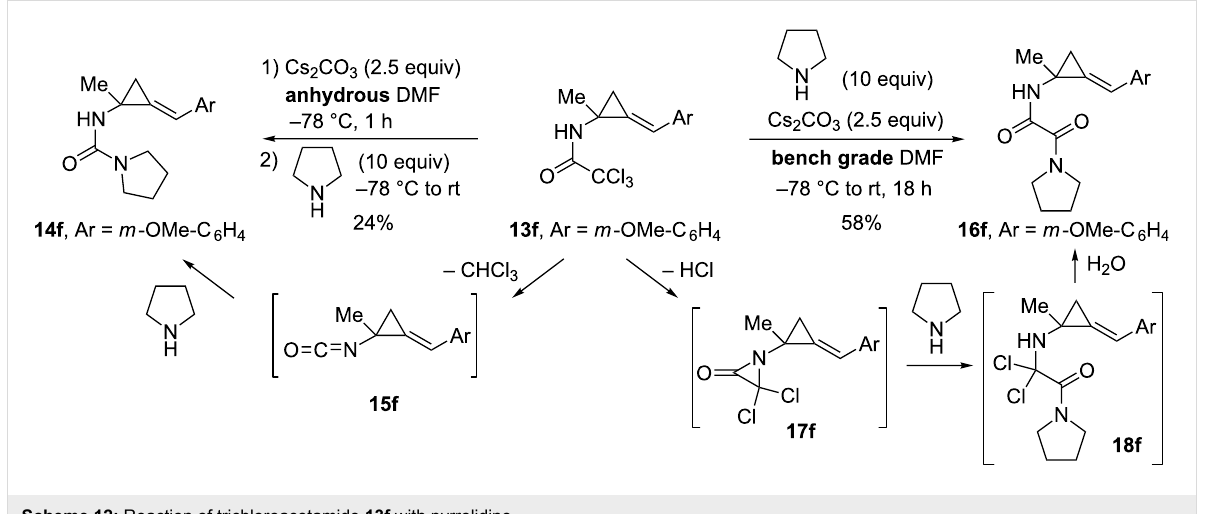
Scheme 12: Reaction of trichloroacetamide 13f with